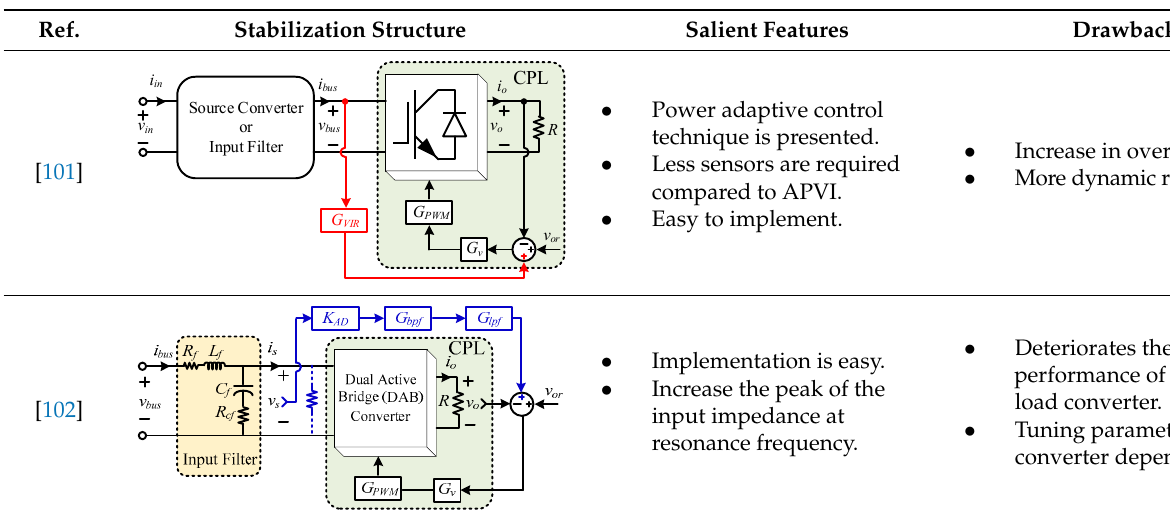
Figure 17. Using auxiliary circuit active damping [104]. 5. The Delays in Digitally Controlled Systems and Their Effect on Active Damping Control Implementation of the AD techniques in the digital domain is an important practical aspect that needs to be taken care of. The control system in the digital platform consists of two types of delays: computational delay and pulse width modulation (PWM) delay [24,105–107]. As synchronous sampling is frequently employed in digitally controlled sys- tems; the computation delay is represented by the interval of time (𝑇 (cid:3046) ) between two sam- ples, which is expressed as 𝐺 (cid:3031),(cid:3004)(cid:3016)(cid:3014) = 𝑒 (cid:2879)(cid:3046)(cid:3021) (cid:3294)